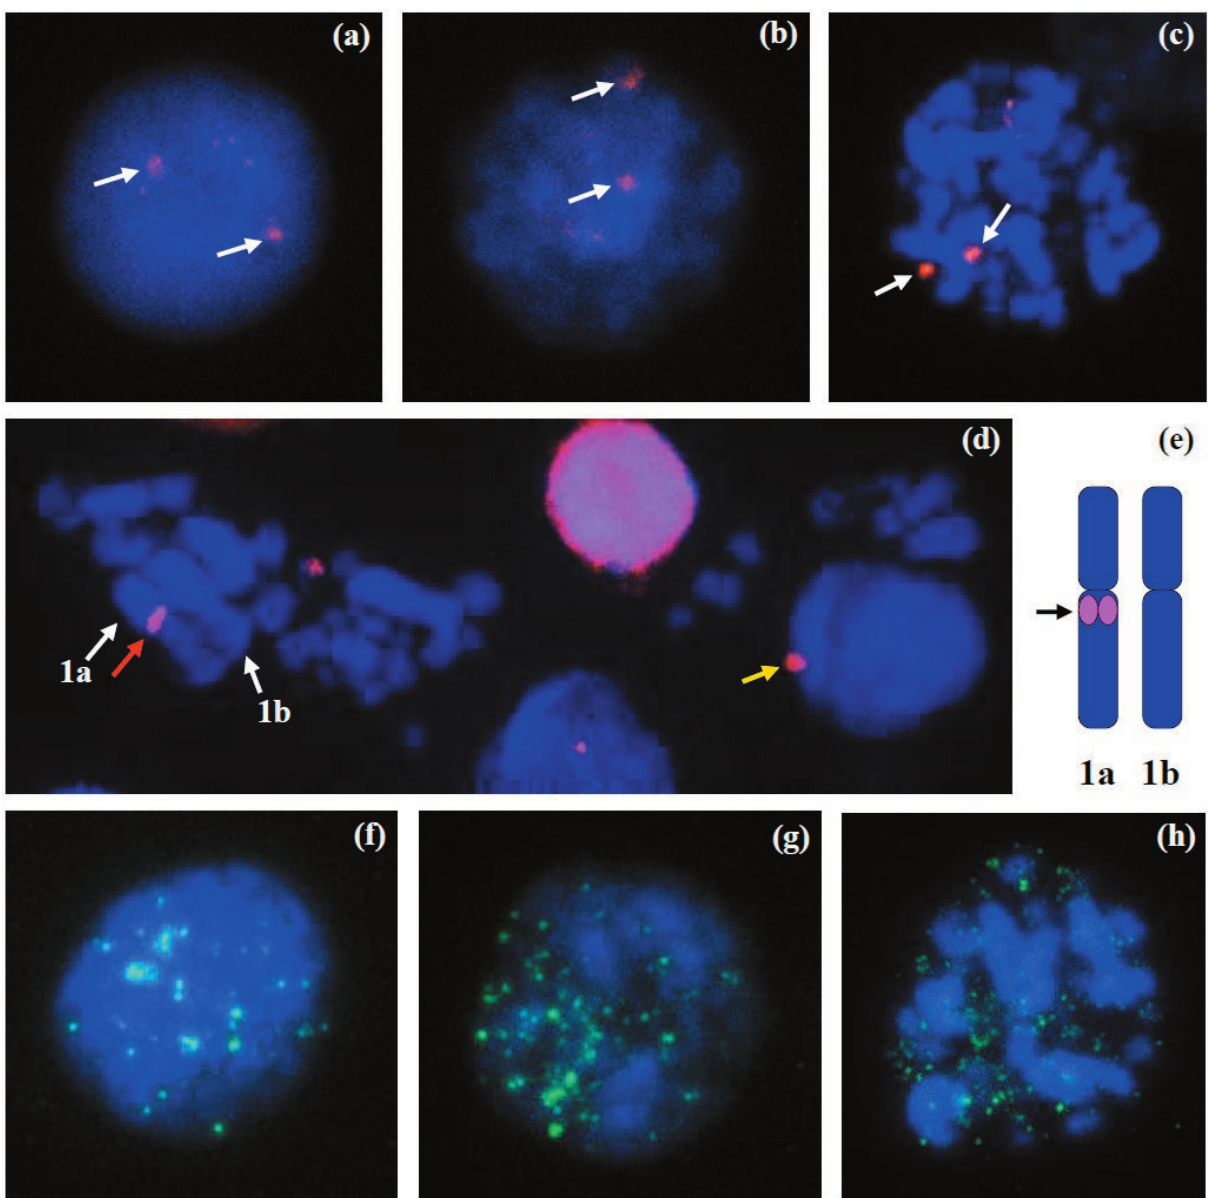
Figure 4. The molecular cytogenetical features of male Tachybaptus ruficollis , including: d(CA) 15 microsatellite signals on two microchromo- somes of interphase (a) prophase (b) and metaphase (c); d(GC) 15 microsatellite signals on only one chromosome of the 1 st pair of metaphase (d, red arrow), interphase (d, yellow arrow) and the position of this signal on idiogram (e); and AGGGTT n telomeric sequences on inter- phase (f), prophase (g) and metaphase